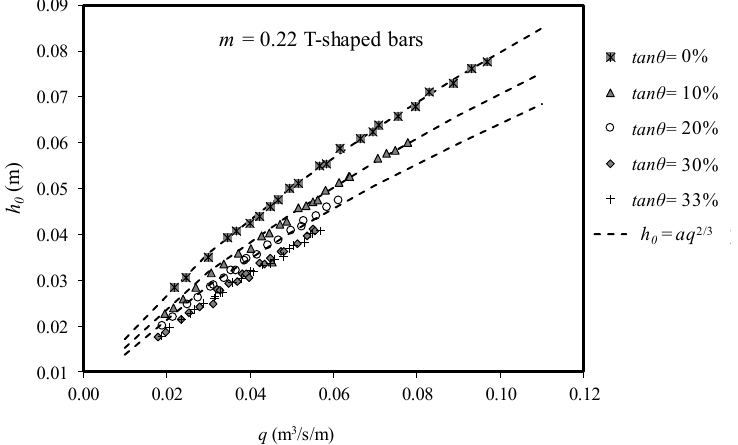
Figure 9. Flow depth at the beginning of the rack h 0 as a function of the incoming flow q . T-shape bars with void ratio m = 0.16.